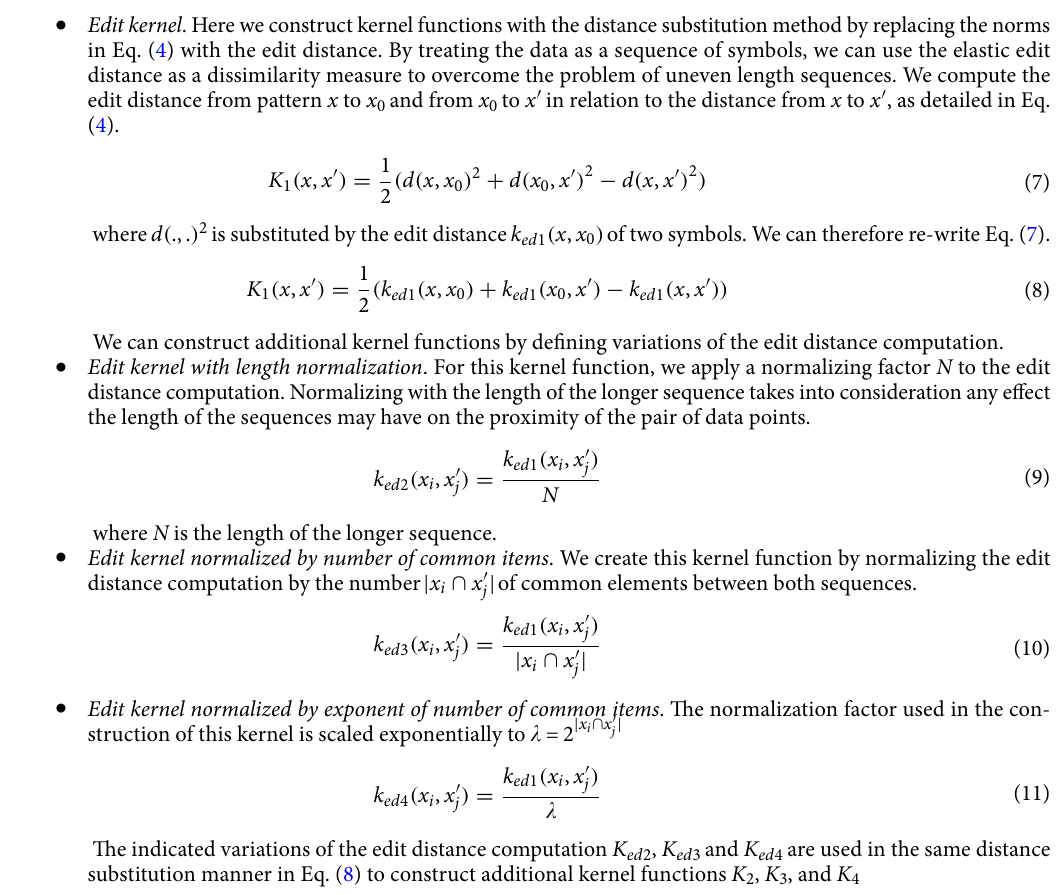
Recall ∗ Precision F1-score = 2 ∗ Recall +